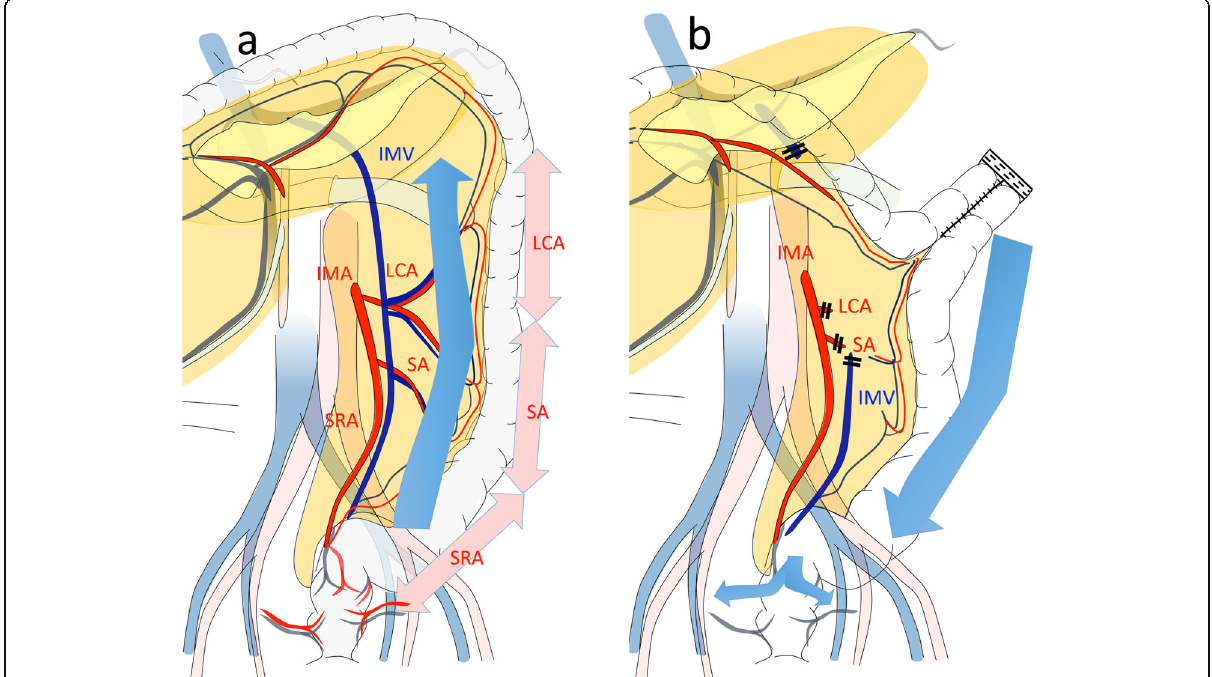
Fig. 3 a The IMV returns from the left transverse colon to the rectum. b When the SRA and SA are preserved and the IMV is dissected both at the inferior margin of the pancreas and at the root of SA (cases 2 – 4) level, venous blood from the anastomosis to the rectum mainly returns via the rectal vein. In case 1, the distal branches of IMV dissected at the root of LCA